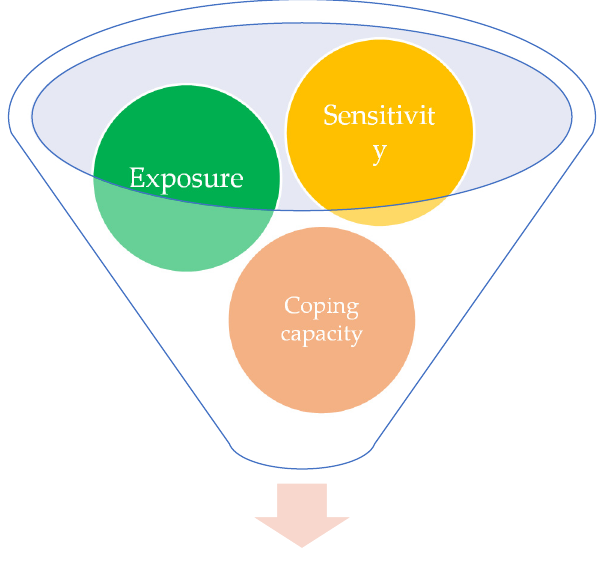
Figure 1. Diagram of the three elements of vulnerability.